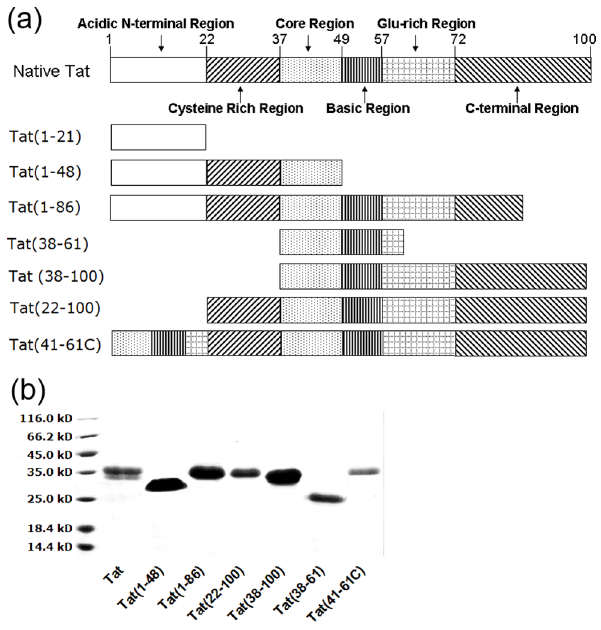
Figure 1. Design, expression and purification of Tat peptides. (a) Design of the seven analytic Tat peptides. (b) Expression and purification of recombinant full-length Tat protein and the six analytic Tat peptides. Recombinant full-length Tat and six analytic Tat peptides were induced by IPTG, and the relative molecular weight (MW) of the expressed products were as follows: 34,540 for Tat, 28,710 for Tat(1–48), 32,890 for Tat(1–86), 32,230 for Tat(22–100), 30,470 for Tat(38–100), 20,670 for Tat(38–61) and 36,850 for Tat(41–61C). The seven expressed products were purified by Ni-NTA column affinity chromatography and SP Sepharose fast flow ion-exchange